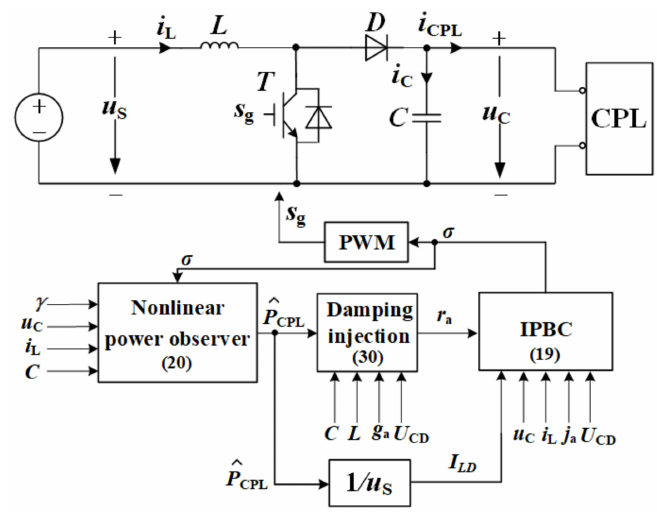
Figure 6. The structure of the proposed control